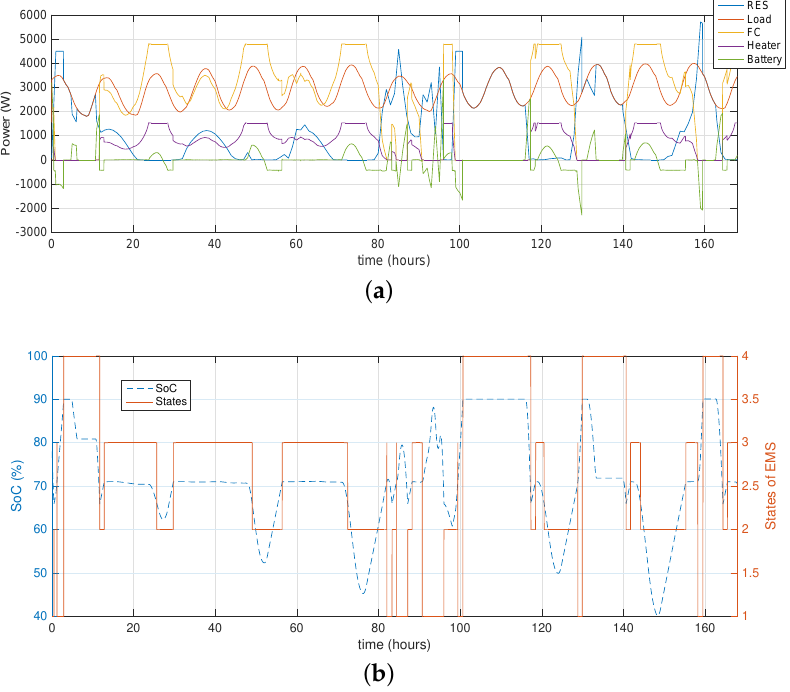
Figure 5. Simulation results: ( a ) HRES power distribution; ( b ) (dashed line) state of charge of the batteries ( SoC ); (solid line) state transitions in the EMS.